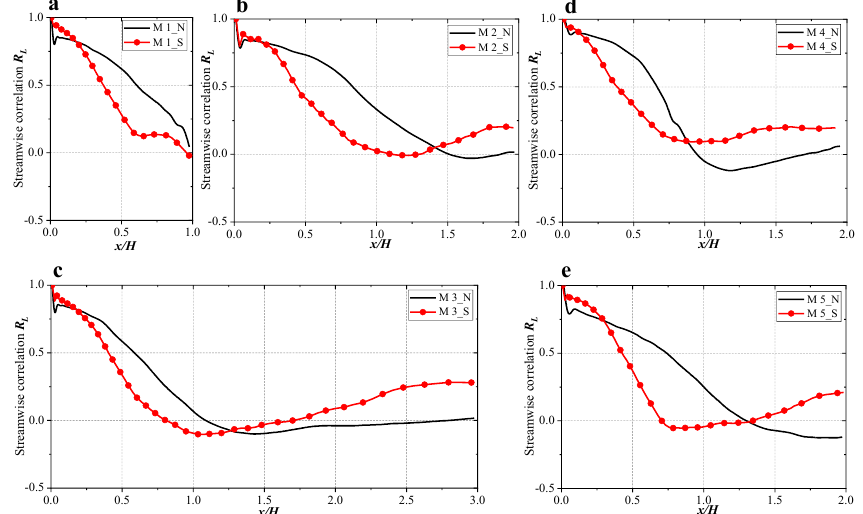
Figure 18. Comparison of streamwise correlation (( a ) M1; ( b ) M2; ( c ) M3; ( d ) M3; ( e ) M4).